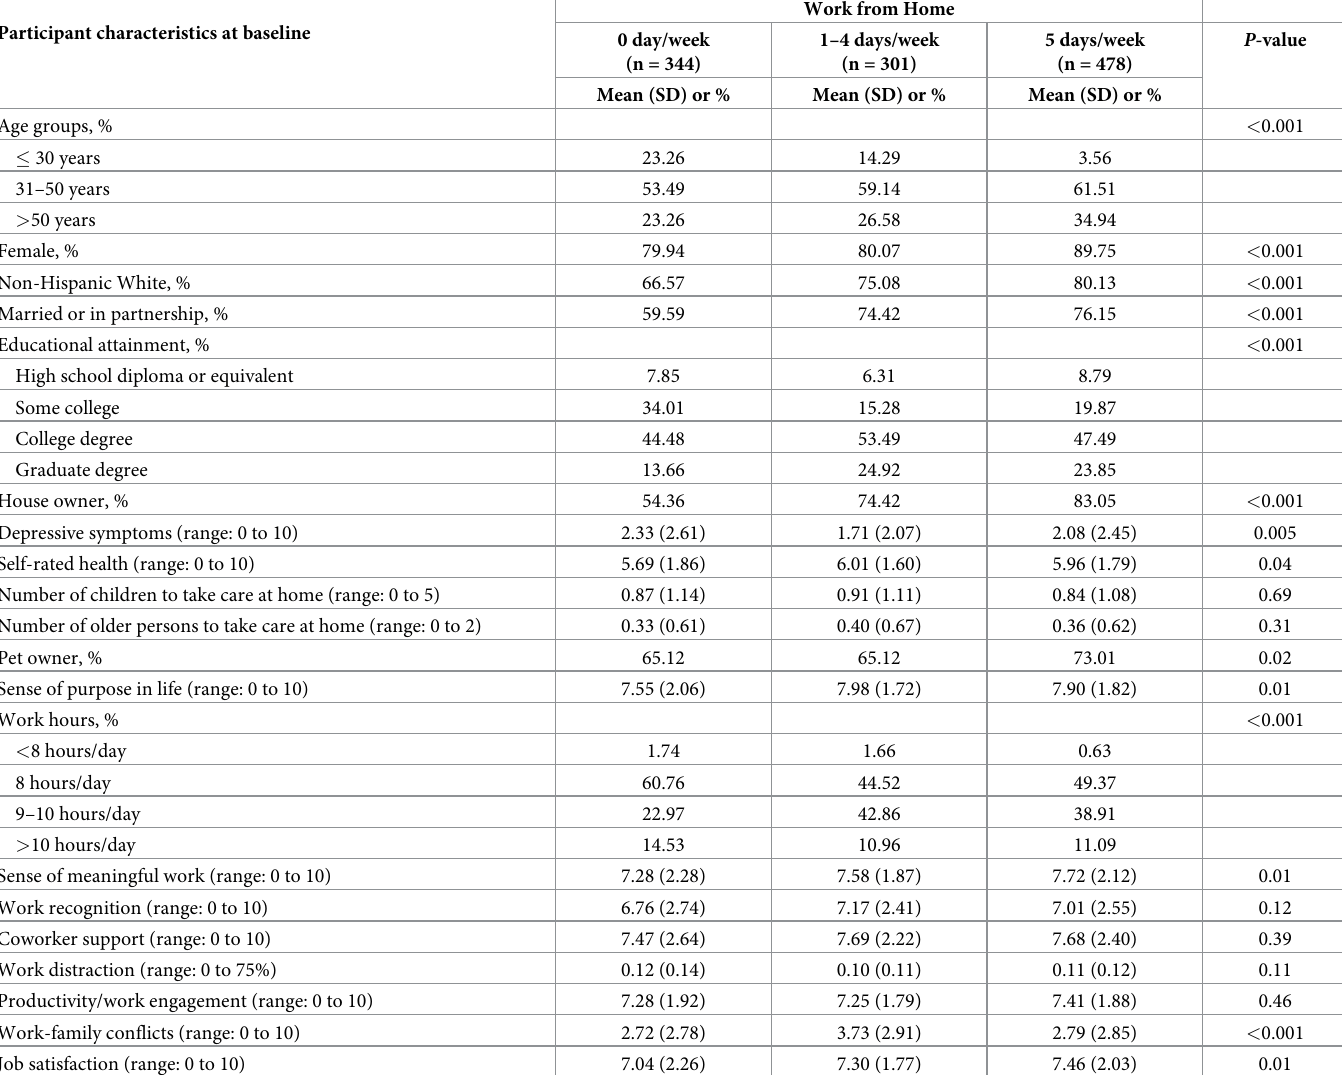
Table 1. Participant baseline characteristics by frequencies of work from home (N = 1,123). Participant characteristics at